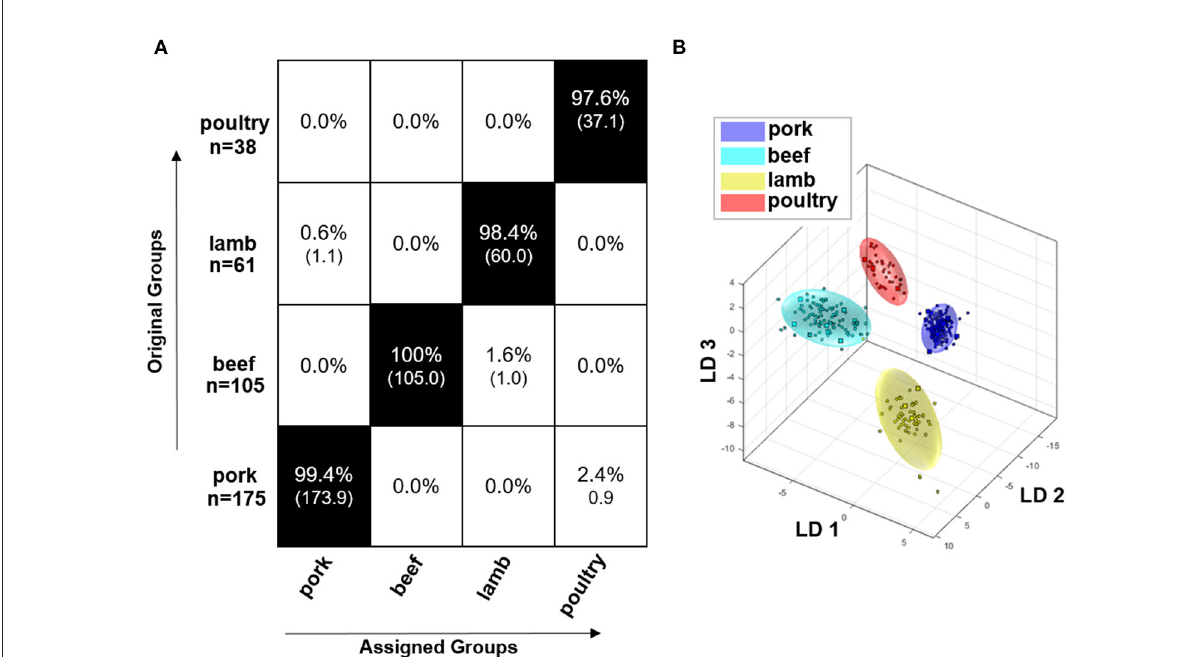
FIGURE4 Results of the Monte Carlo embedded cross-validation on the performance of the obtained classification model of PCA/LDA to predict the species of meat using 1 H NMR data of polar meat metabolites. (B) shows the discrimination space of a cross validation step. The training set for model building of each class is symbolized by its 95% confidence ellipsoid, and the test set samples are indicated as circles. (A) shows the confusion matrix of the embedded MCCV. The x-axis and the y-axis show the assigned class and the correct class, respectively. The confusion matrix shows the classification assignment in numbers and the accuracies about the probability of the prediction result in percent. Experiment used: noesygppr1d_d7.eba ; 0.50–9.50 ppm; 1,000 buckets; exclusion of the residual water signal (4.84–5.10 ppm); normalization: − 0.50 to 0.50 ppm; log transformation; PCA dimensions: 14; 10 CV; 10 Monte Carlo